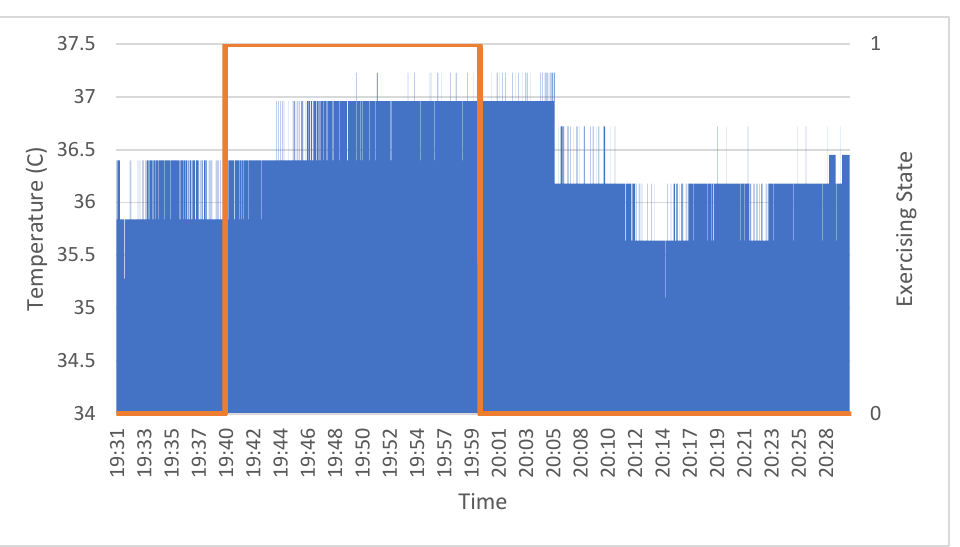
Figure 11. Exercise and temperature status.